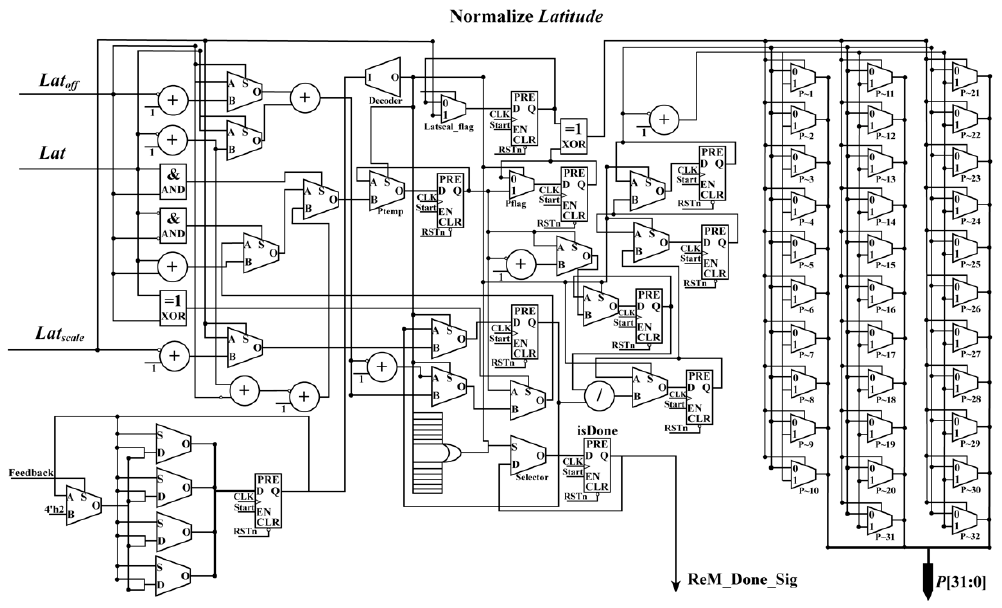
Figure 4. Schematic diagram of normalizing Latitude .